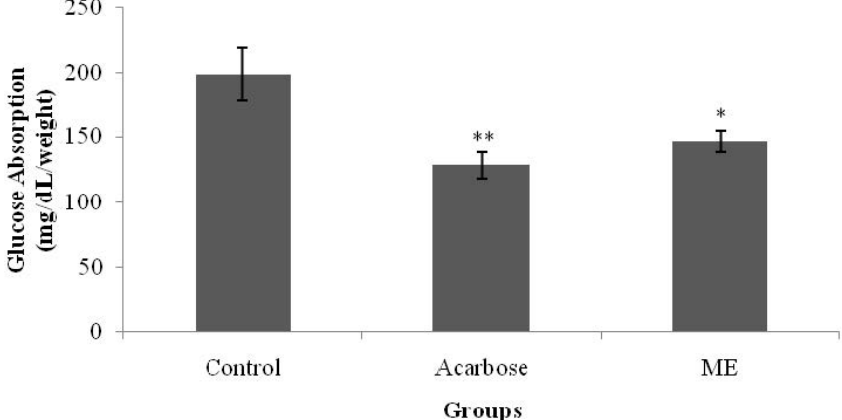
Figure 5. The effect of methanolic extract (ME) of S. polyanthum on glucose absorption of everted rat jejunum. Values are expressed as mean ± standard error of the mean (SEM) ( n = 5); * p < 0.05, ** p < 0.01 compared with control group.